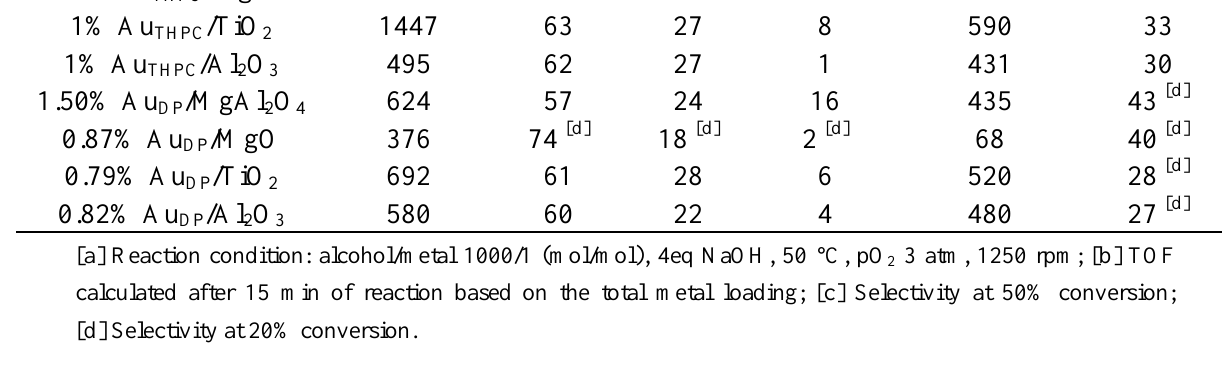
Figure 2. Reaction profiles for glycerol oxidation using ( a ) Au